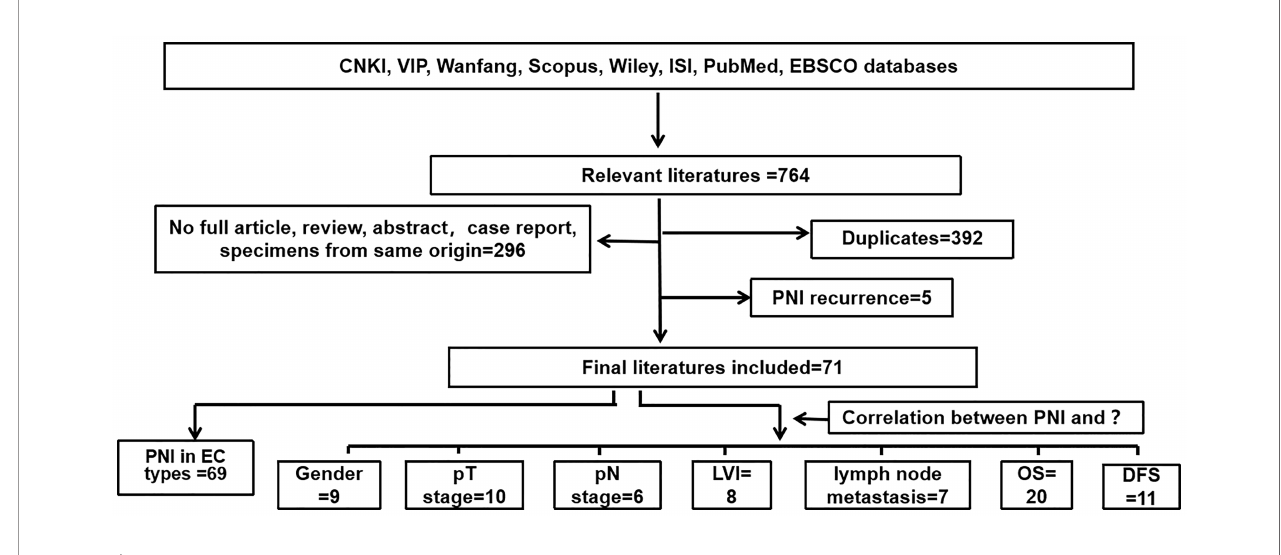
FIGURE 1 | Flow chart of the database